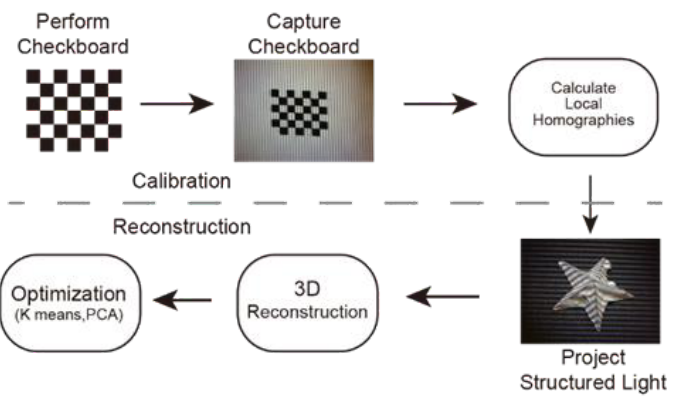
Figure 1. Reconstruction flow map.